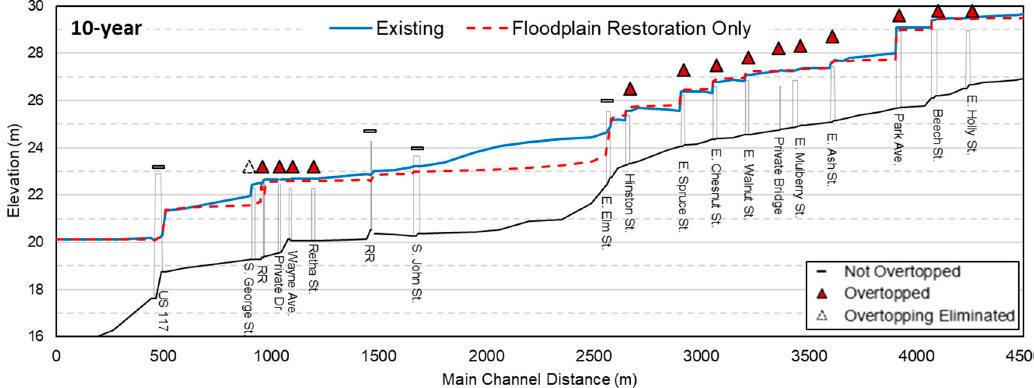
Figure 8. Water surface profiles for the Existing Condition and the Restoration Only scenario for the 10-year event.